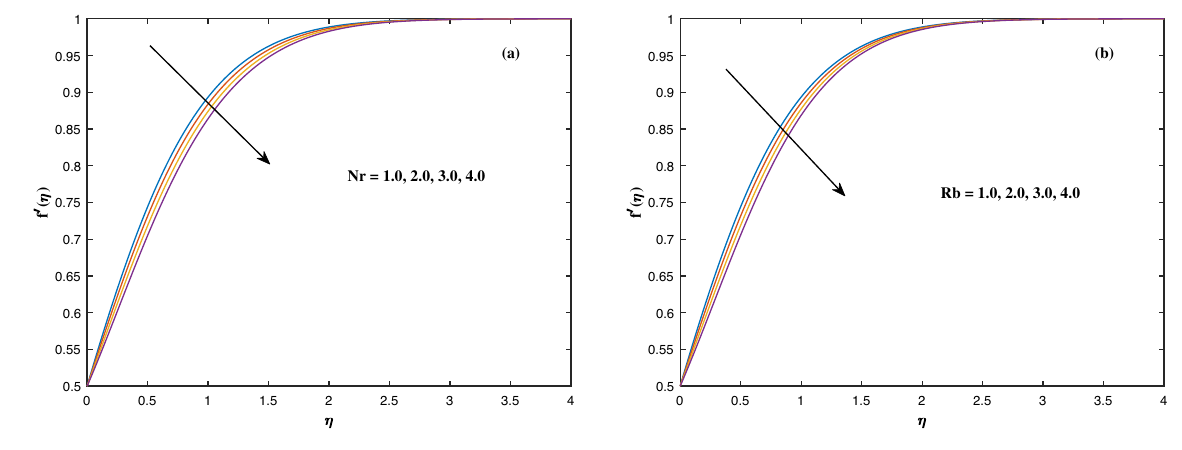
Figure 4. Fluctuation in f ′ (η) with ( a ) Nr and ( b ) Rb .